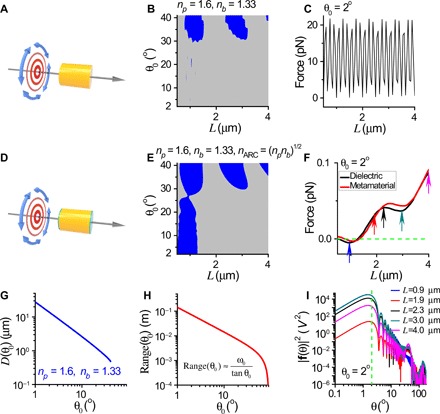
OPF acting on a dielectric cylinder of diameter D and length L.Schematic illustration without ARC (A) and with ARC (D). (B and E) Phase space plots for the OPF acting on the dielectric cylinders without [see (A)] and with [see (D)] ARC, respectively, with D(θ0) shown in (G). Blue and gray regions indicate pulling and pushing forces, respectively. (C) Optical forces acting on the cylinder shown in (A) versus the length of the cylinder L when θ0 = 2o. (F) Black: Optical forces acting on the cylinder shown in (D) versus the length of the cylinder L when θ0 = 2o. Red: The OPF acting on a metamaterial cylinder made of εr = npnb and μr = np/nb. (G) Diameter D(θ0) of the cylinder at which the FWM is excited. (H) Range of the Bessel beam versus θ0. (I) Angular distribution of the scattered fields for pulling (blue) and pushing (others) forces, marked by arrows in (F) with corresponding colors.